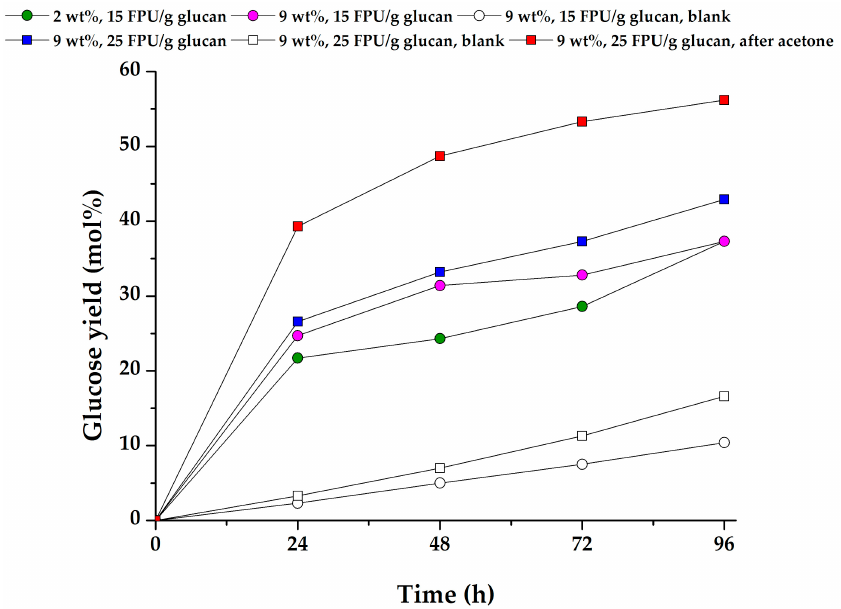
Figure 7. Kinetics of enzymatic hydrolysis of the CRR recovered from run 13 in Tables 1 and 2 (coloured curves) and raw Arundo donax L. as blank (white curves).